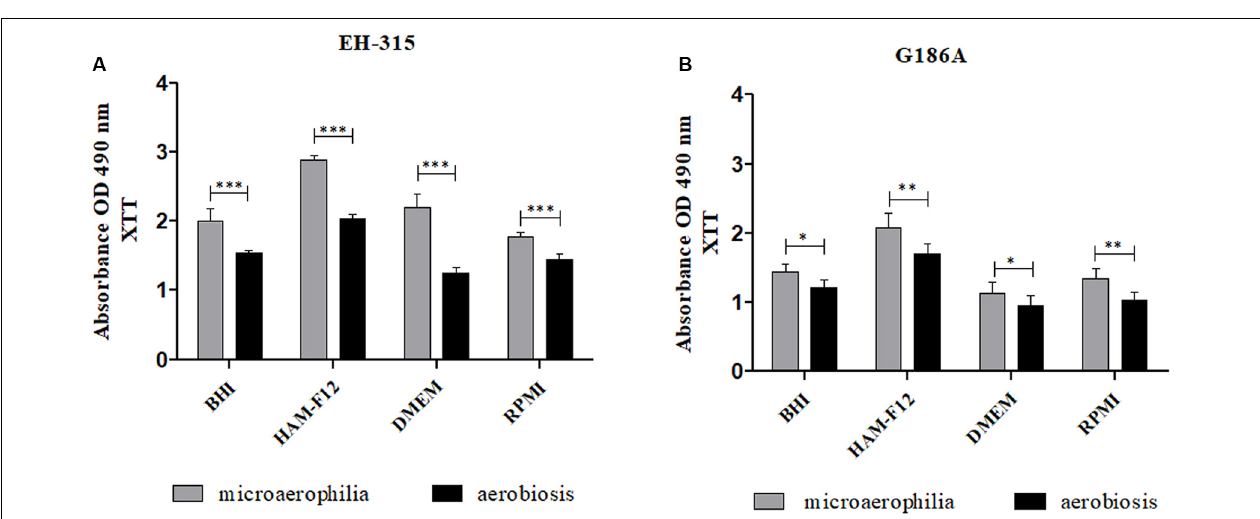
Frontiers in Microbiology |